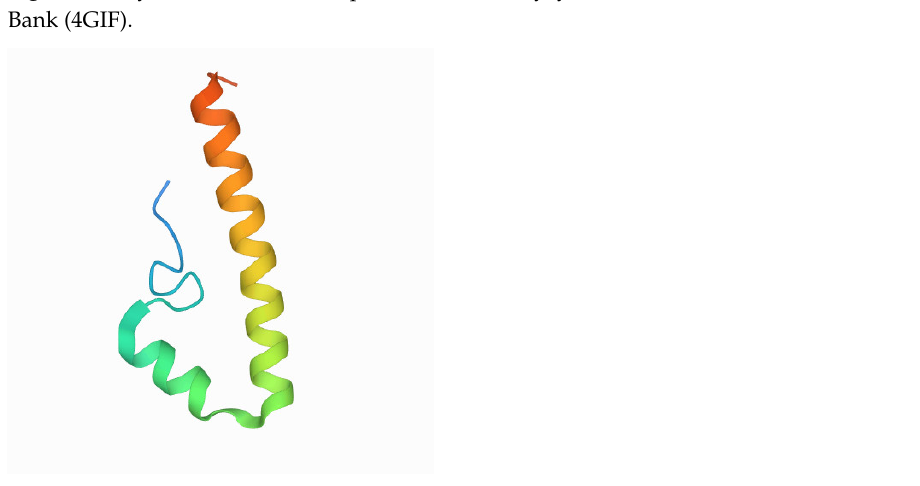
Figure 3. Asymmetric molecule example (S. cerevisiae Rtf1). Extracted from the Protein Data Bank (5EMX).